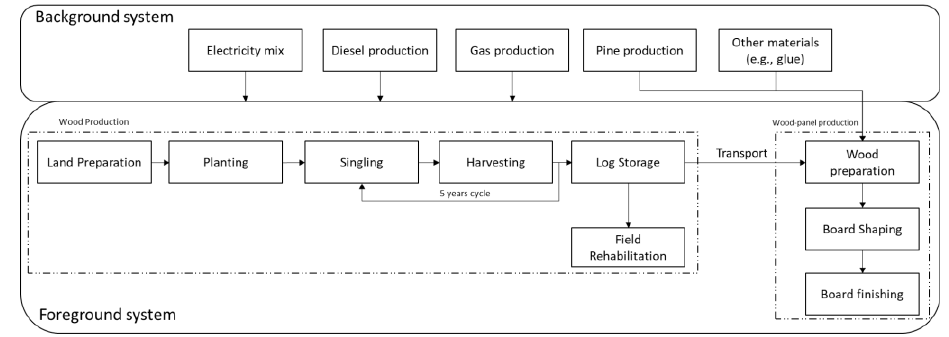
Figure 1. Summary of system boundaries for the case study of wood panel boards.